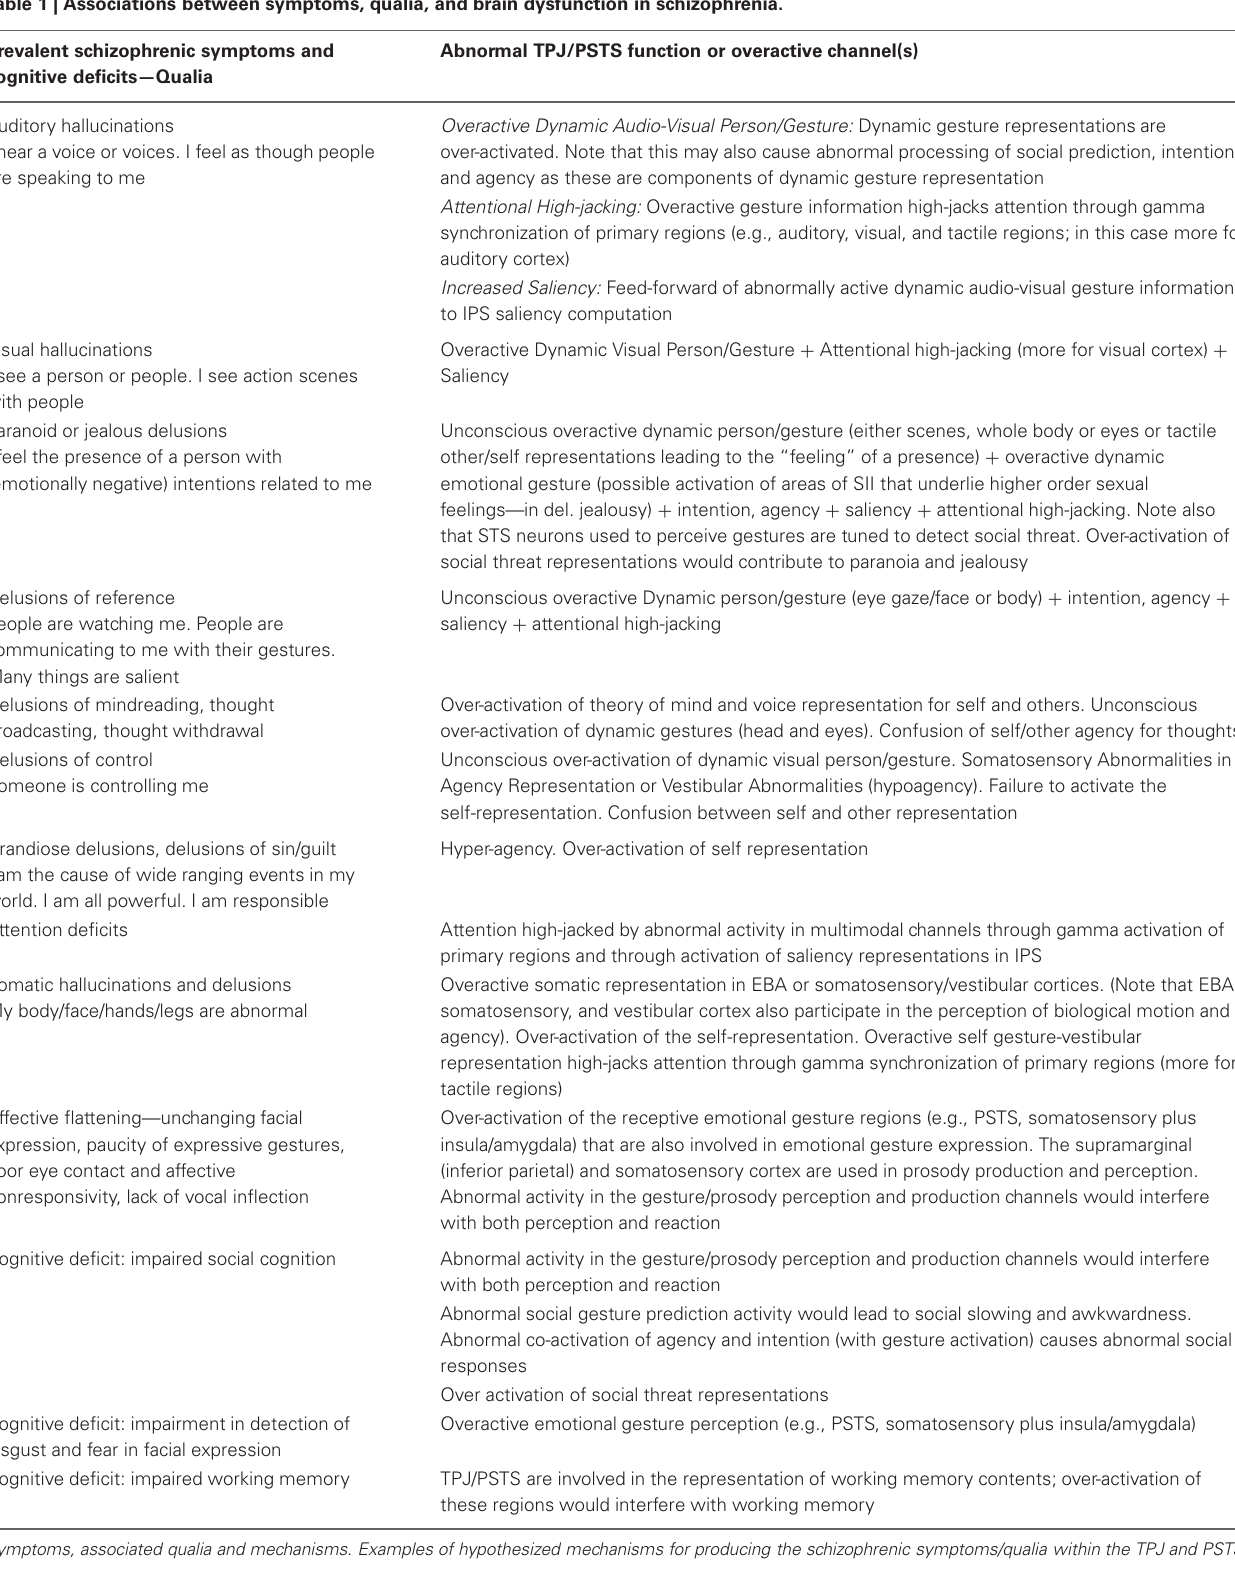
Table 1 | Associations between symptoms, qualia, and brain dysfunction in schizophrenia. Prevalent schizophrenic symptoms